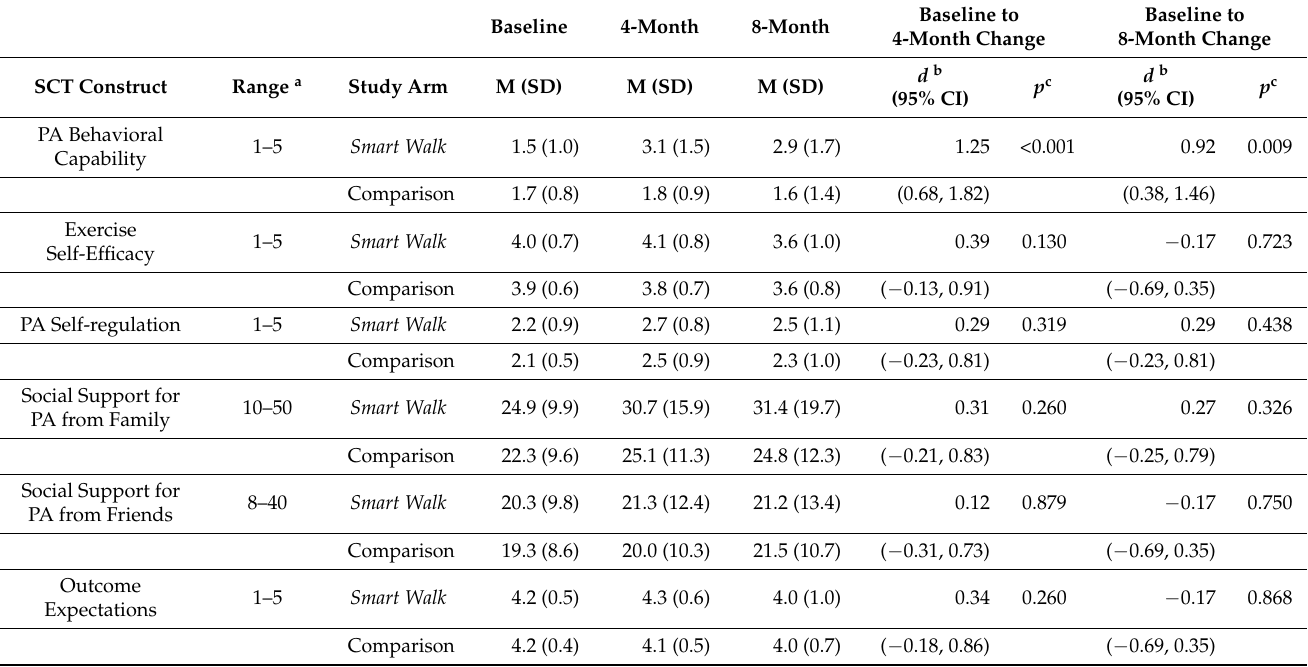
Table 9. Social Cognitive Theory